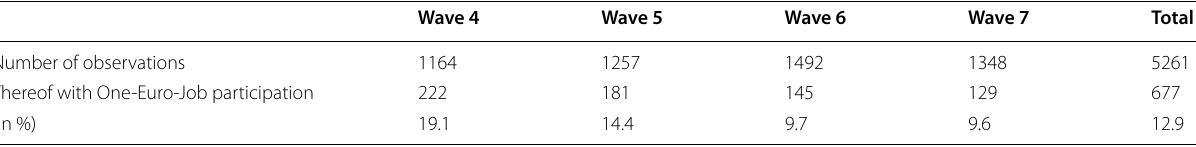
Table 3 Number of observations by wave. Source: PASS_0613_v1, Statistics Department of the German Federal Employment